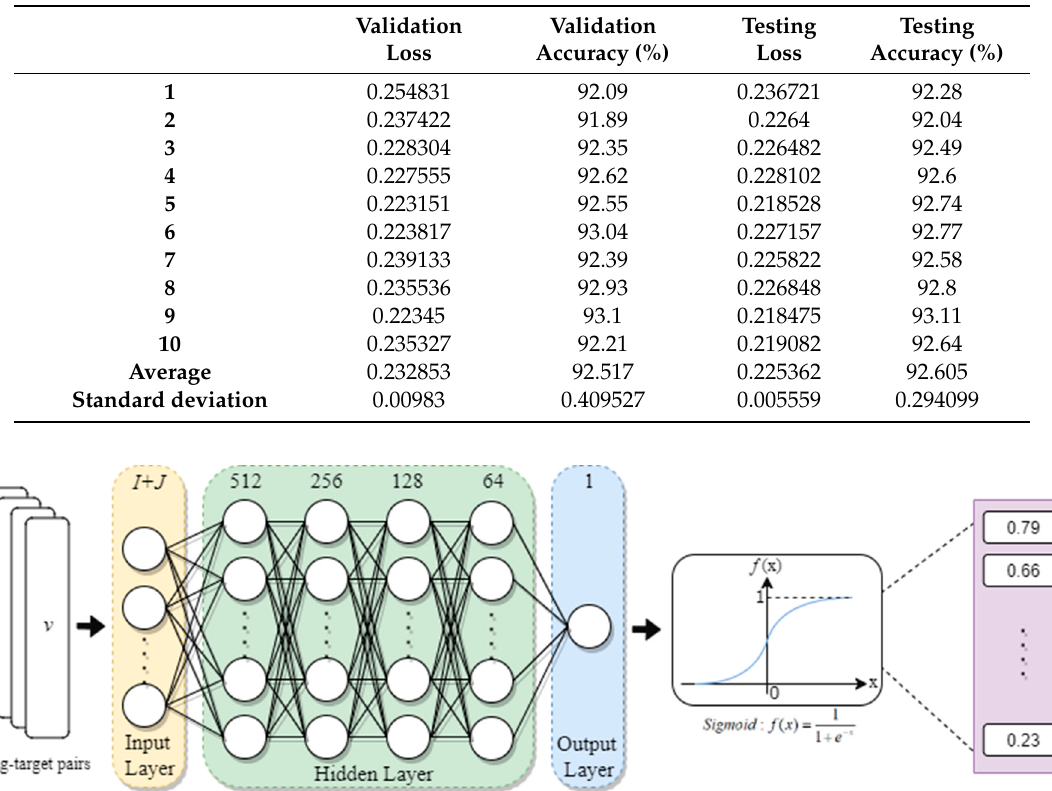
Table 5. Model performance (10-fold cross validation).